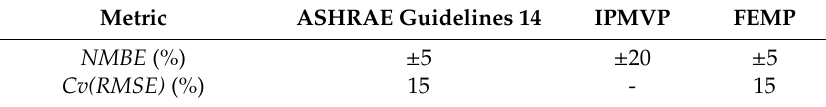
Table 4. Threshold limits of metrics for model calibration with monthly data.